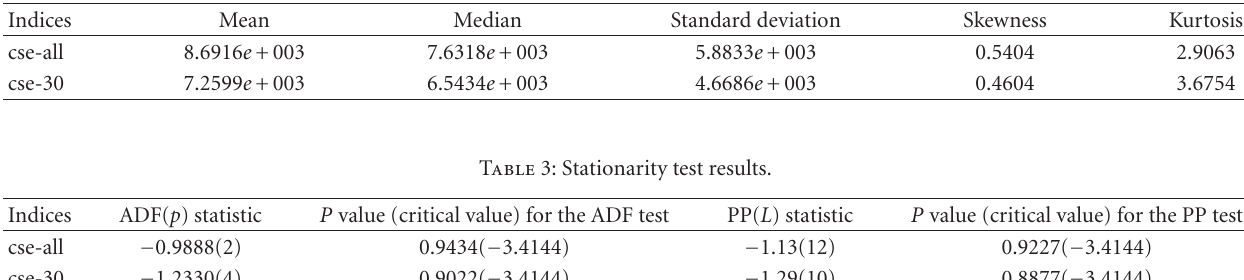
Table 2: Numerical properties of the selected indices.